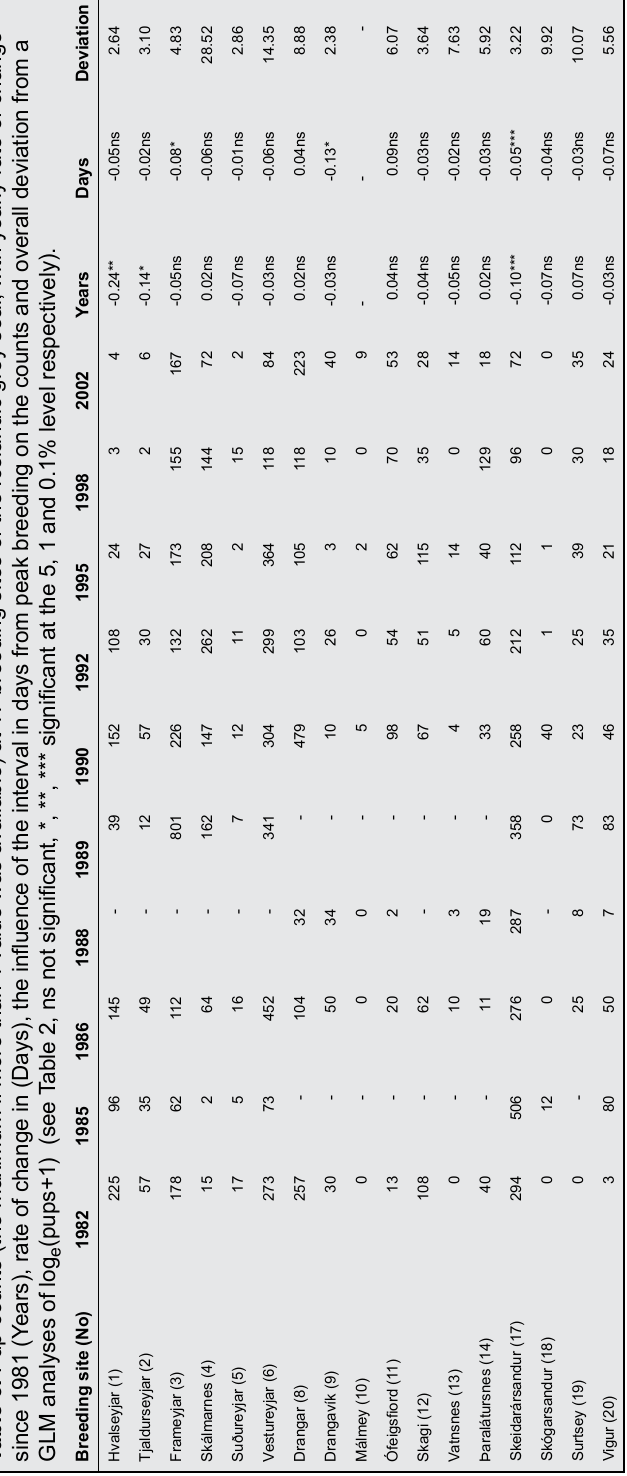
Grey seals in the North Atlantic and the